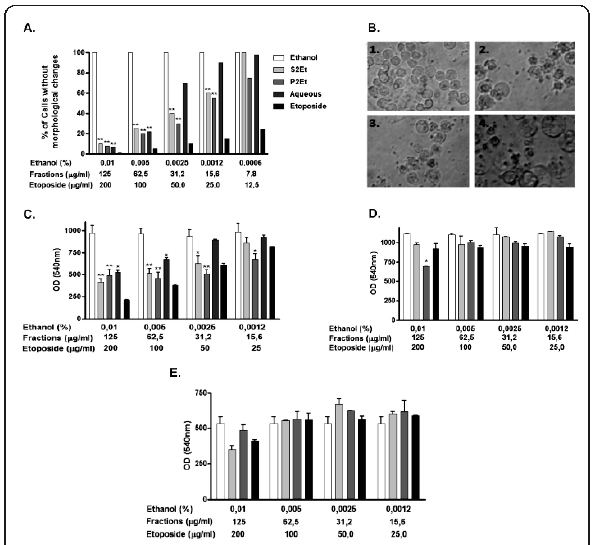
Figure 2 Induction of morphological changes and cytotoxicity in K562 cells by C. spinosa fractions without affecting normal human cells . K562 (A, B, C), Fibroblasts (D), or PBMCs (E) cells were treated with C.spinosa fractions at different concentrations for 48 h. Morphological changes were evaluated by direct observation using a light microscope at a magnification of 40X (B: 1. Ethanol; 2. S2Et; 3. P2Et; and 4. Etoposide). Cell cytotoxicity was estimated using the MTT assay (C, D, and E). Ethanol and etoposide were used as negative and positive controls, respectively. The results of six experiments are shown.